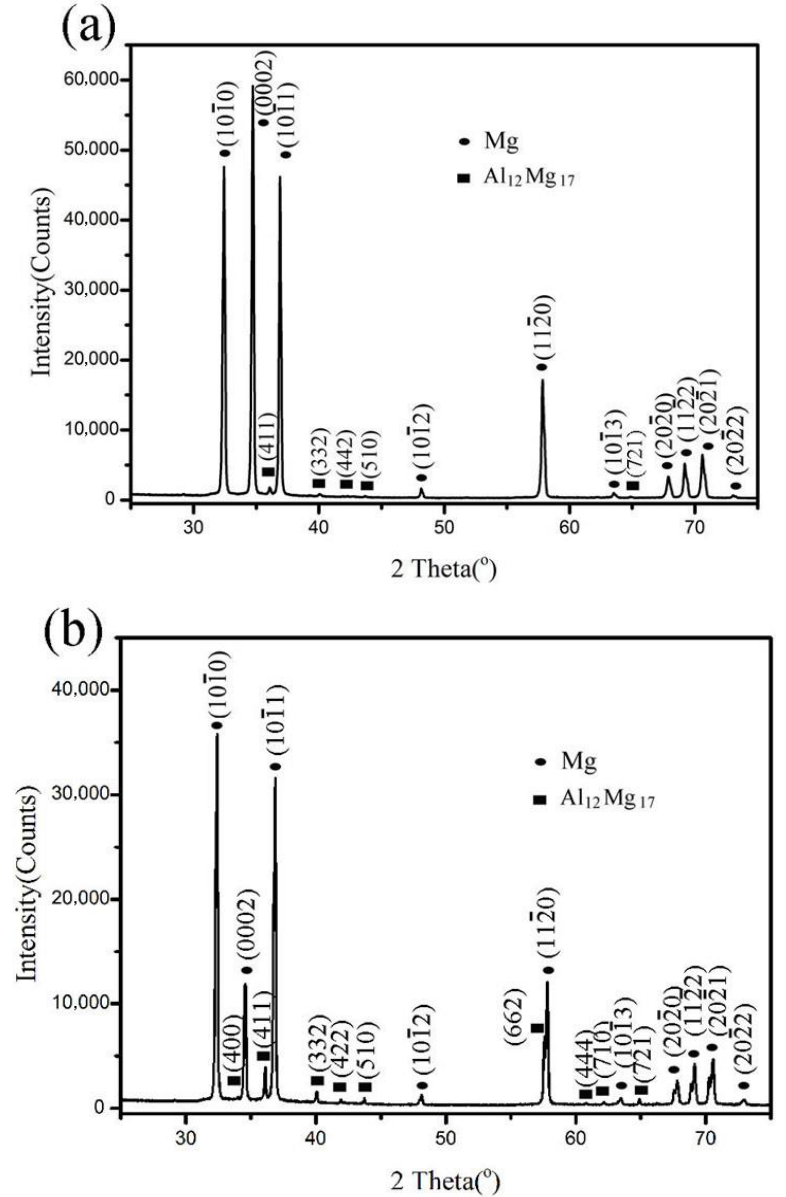
Figure 6. XRD patterns of ( a ) the sample subjected to 175 MPa and subsequent aging at 170 °C for 3 h and ( b ) the sample subjected to simultaneous loading and aging under the same condition. Table 2. Yield stress as a function of different processes in this study.